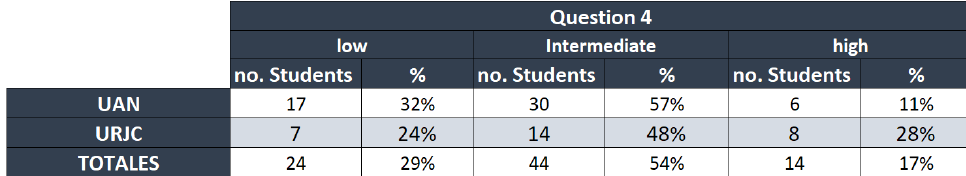
Figure 10. Distribution of responses to Question 4 according to the three grades of reflection (low, intermediate, high) by giving the number of students (no.students) classified and their percentage (%) of the total in their row (UAN, URJC and